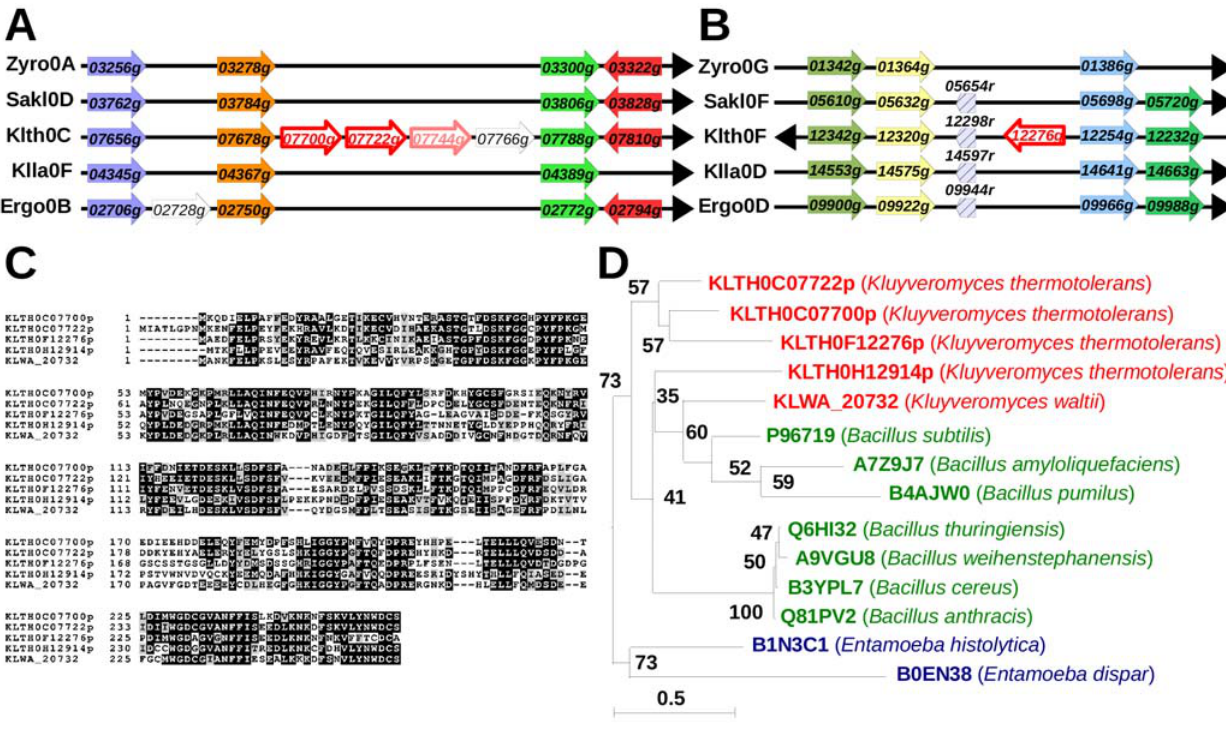
Figure 4. Duplicated HGT candidates in K. thermotolerans . (A) Part of the conserved synteny block surrounding KLTH0C07700g and KLTH0C07722g tandem genes. Same legend as Figure 3A. (B) Part of the conserved synteny block surrounding KLTH0F12276g gene. Same legend as Figure 3A. (C) Sequence alignment of proteins from K. thermotolerans and K. waltii . (D) Phylogenetic tree reconstructed from sequence alignment of 100 sites of K. thermotolerans protein family members, K. waltii gene, bacterial (green) and amoebal (blue) proteins. Bootstrap values are indicated next to the nodes and branch length scale is shown at bottom left.